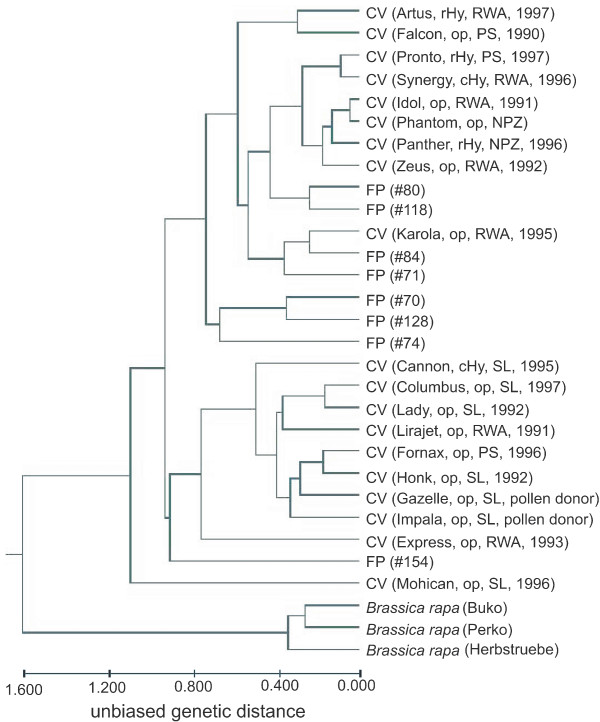
Relationship among samples based on Nei's [40]unbiased genetic distance and UPGMA clustering [43]. FP = feral populations, CV = commercial varieties; variety type: OP = open pollinated, cHy = composite hybrid, rHy = restored hybrid. Seed company: NPZ = Norddeutsche Pflanzenzucht, PS = Probstdorfer Saatzucht, RWA = Raiffeisen Ware Austria, SL = Saatbau Linz. The year of approval for each variety is also indicated.